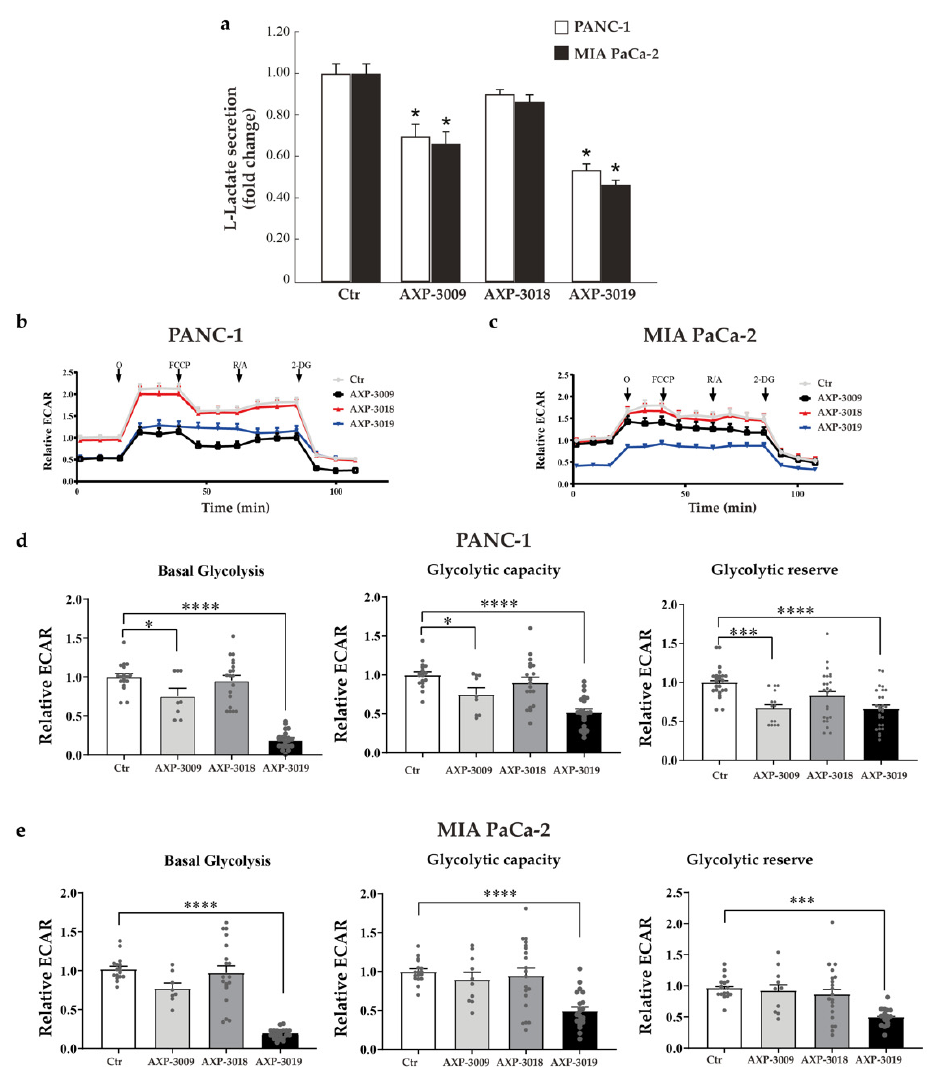
Figure 4. Glycolytic metabolism in PDAC cell lines. ( a ) Cells were seeded in 96-well plate and incubated with 10 µ M of 3-bromo-isoxazoline derivatives for 48 h. Culture medium has been isolated and the amount of L-lactate analysed. Representative graphs of ECAR profiles of PANC-1 ( b ) and MIA PaCa-2 ( c ) treated with 10 µ M of 3-bromo-isoxazoline derivatives for 48 h; O = oligomycin; FCCP = Carbonyl cyanide 4-(trifluoromethoxy)phenylhydrazone; R/A = Rotenone/Antimycin A; 2-DG = 2-Deoxy-D-glucose. Glycolytic parameters ( d , e ) were normalized on the total DNA content per well, calculated as detailed in Material and Methods and expressed as fold-change compared to untreated controls. Statistical analysis was performed with one-way ANOVA and Dunnett’s multiple comparisons test * p < 0.05,*** p < 0.005, **** p <